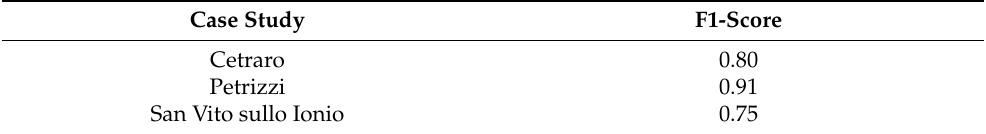
Table 3. Geographic transferability performance of U-Net model considering only buildings falling in landslide risk Table 2. Geographic transferability performance of U-Net model considering the entire built-up area.